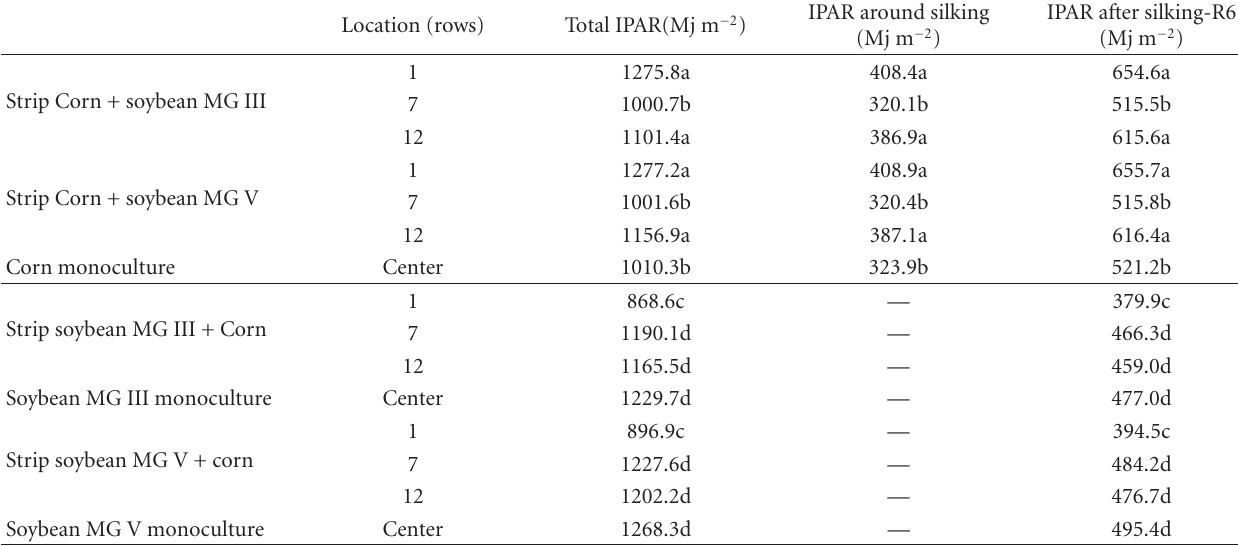
Table 1: PAR interception (IPAR) (Mj m − 2 ). Locations 1, 7, or 12, corresponds to the northern, central, and southern rows, respectively. In monoculture, measurements were made in the center of the plot. Means in a column followed by same letter are not significantly di ff erent ( P < 0 . 05).